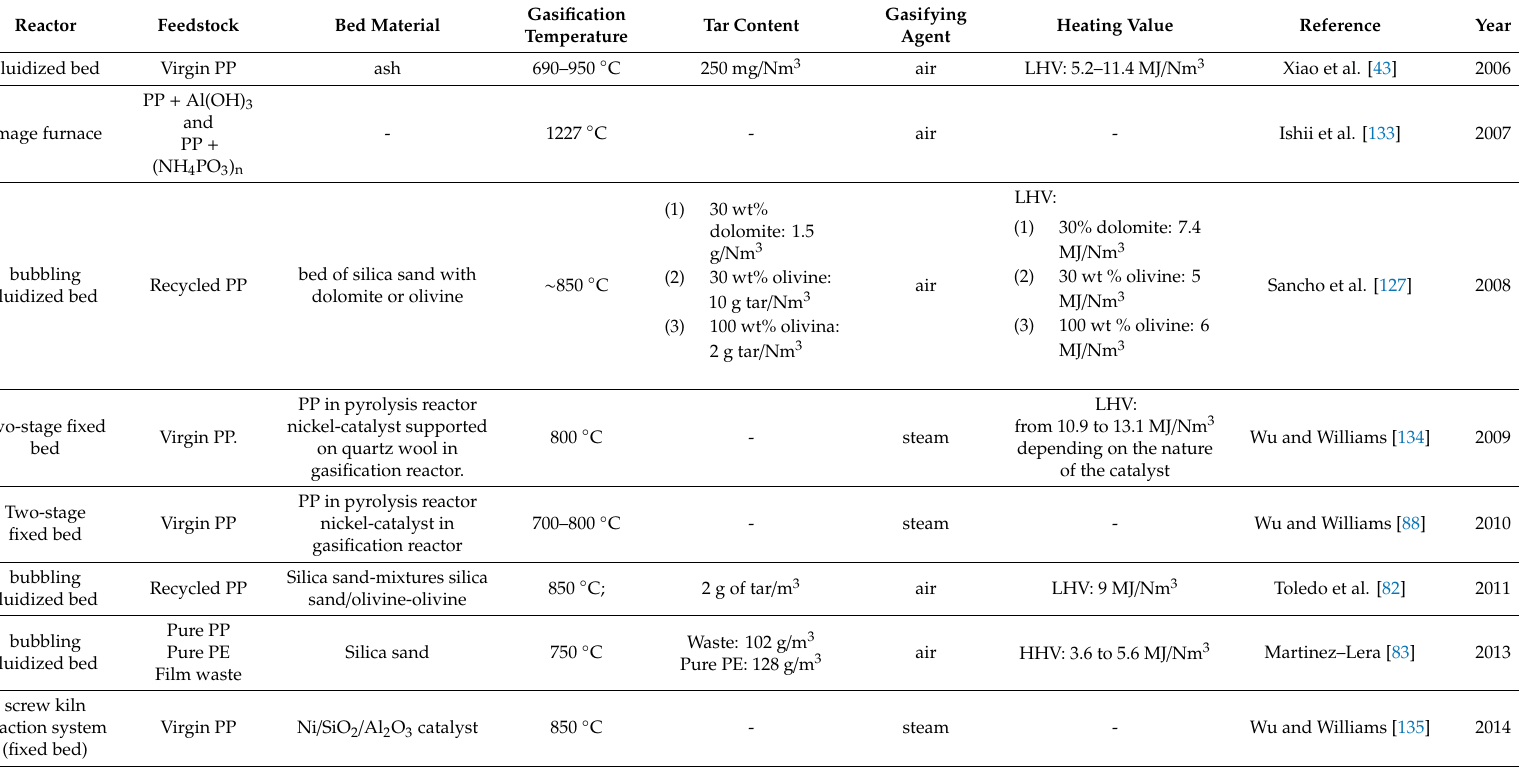
Table 3. Polypropylene gasification summary